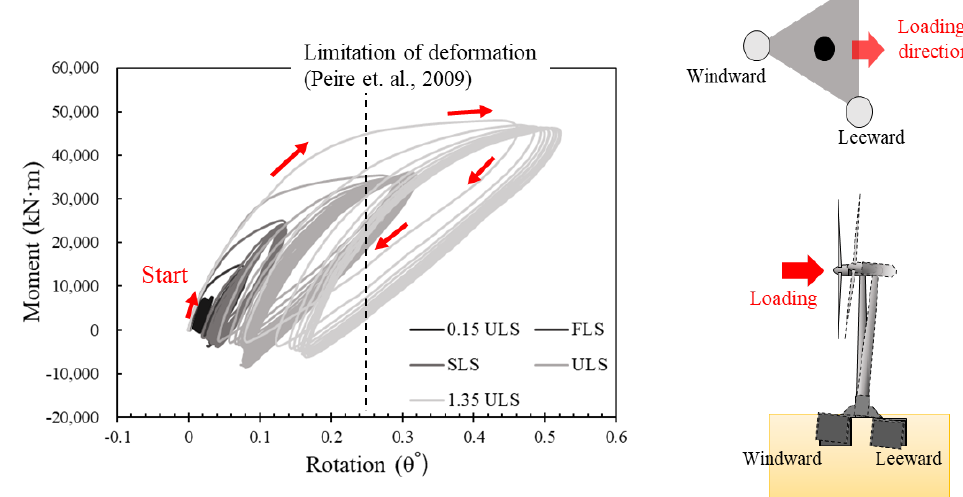
Figure 9. Moment – rotation curve of cyclic loading tests. Figure 9. Moment–rotation curve of cyclic loading